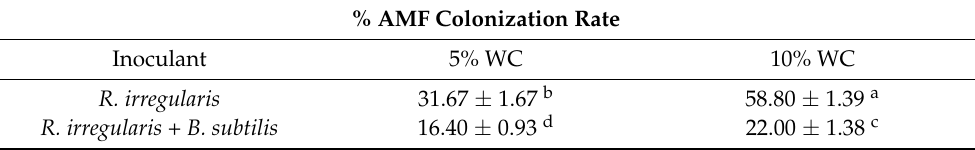
Table 3. Mean % colonization ( ± SE) of L. sativa roots by AMF after inoculation with R. irregularis or co-inoculation with R. irregularis and B. subtilis in dry (5% WC) and wet (10% WC) pots. Different superscripts letters denote the differences in % colonization in relation to the joint effect of water regime x inoculant